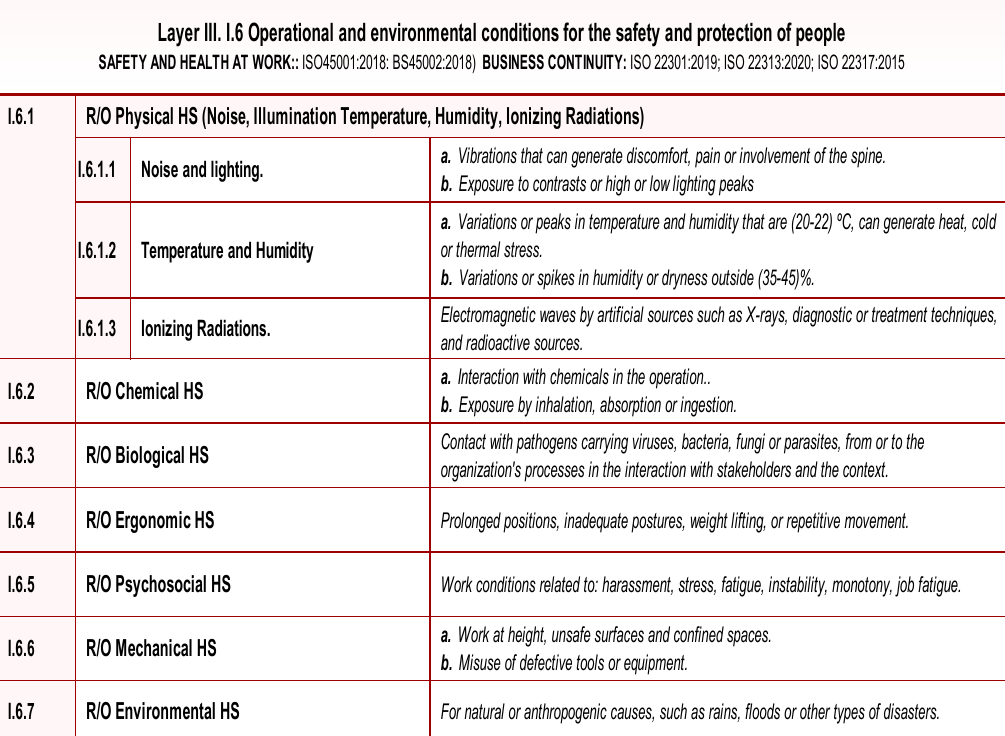
/ O. Layer III: I.6.